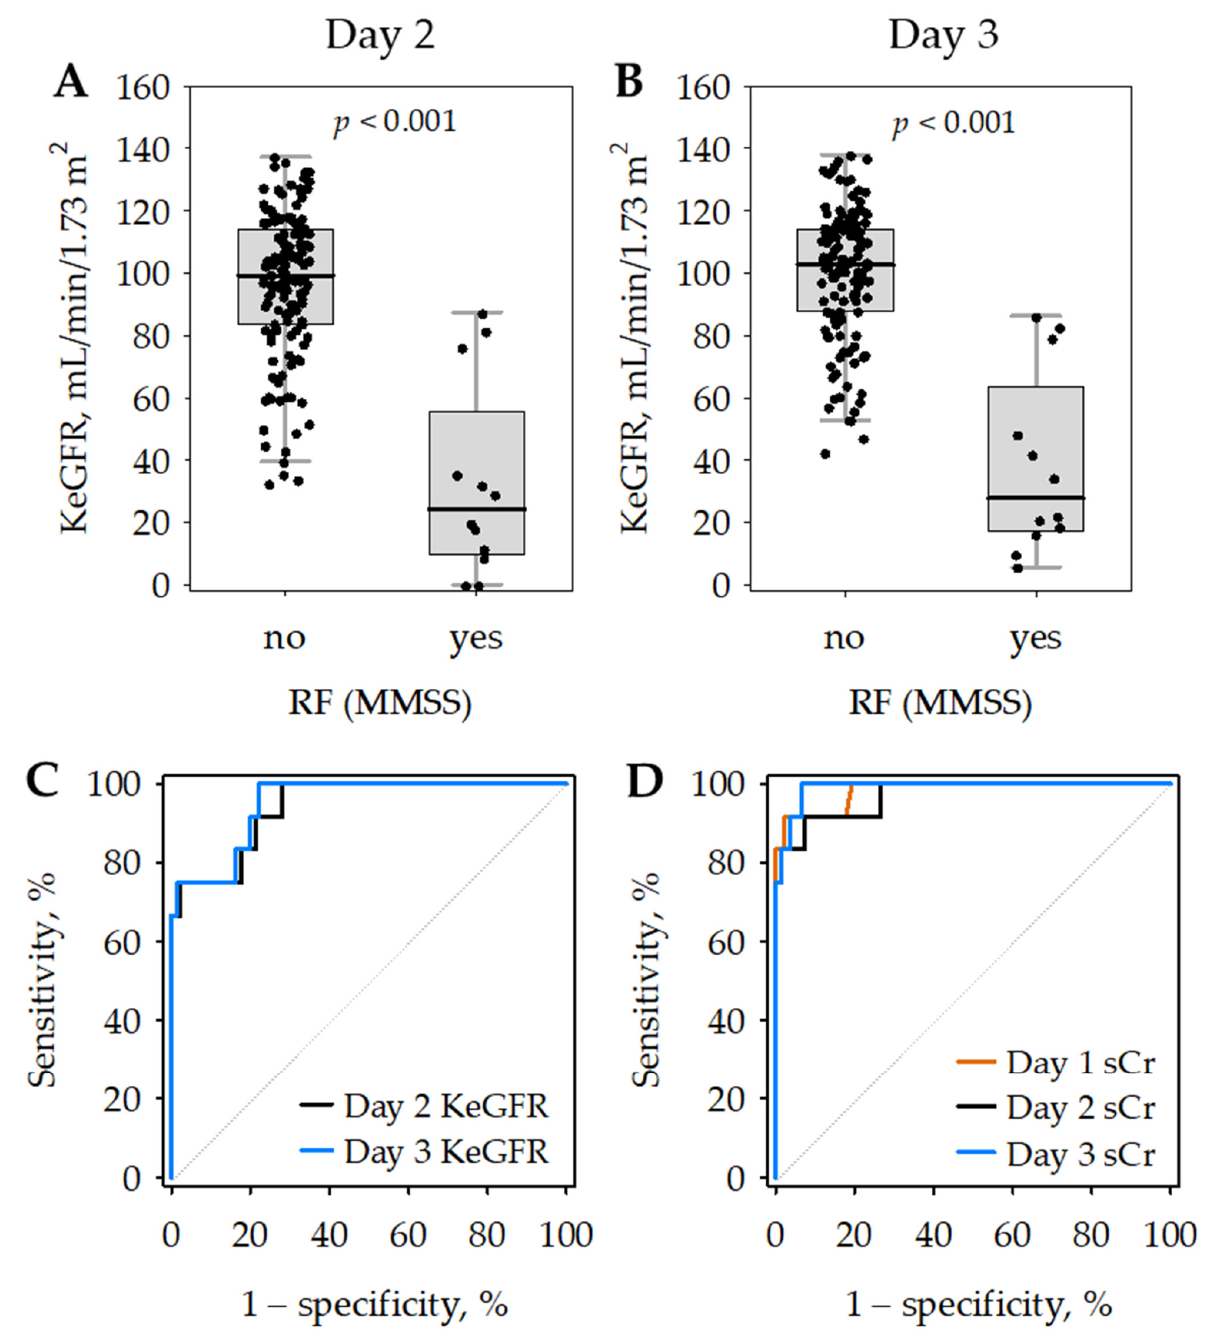
Figure 2. Kinetic estimated glomerular filtration rate (KeGFR) values on day 2 ( A ) and day 3 ( B ) of hospital stay according to the diagnosis of renal failure (RF) on days 1 to 3 based on the modified Marshall scoring system (MMSS). Data are shown as median (central line), interquartile range (box), non-outlier range (whiskers) and raw data (points). Receiver operating characteristic (ROC) curves showing the diagnostic accuracy of day 2 (black) and day 3 (blue) KeGFR for renal failure defined according to MMSS ( C ). For comparison, ROC curves for serum creatinine (sCr) as a marker of renal failure are presented on panel ( D ) (day 1—orange; day 2—black; day 3—blue).